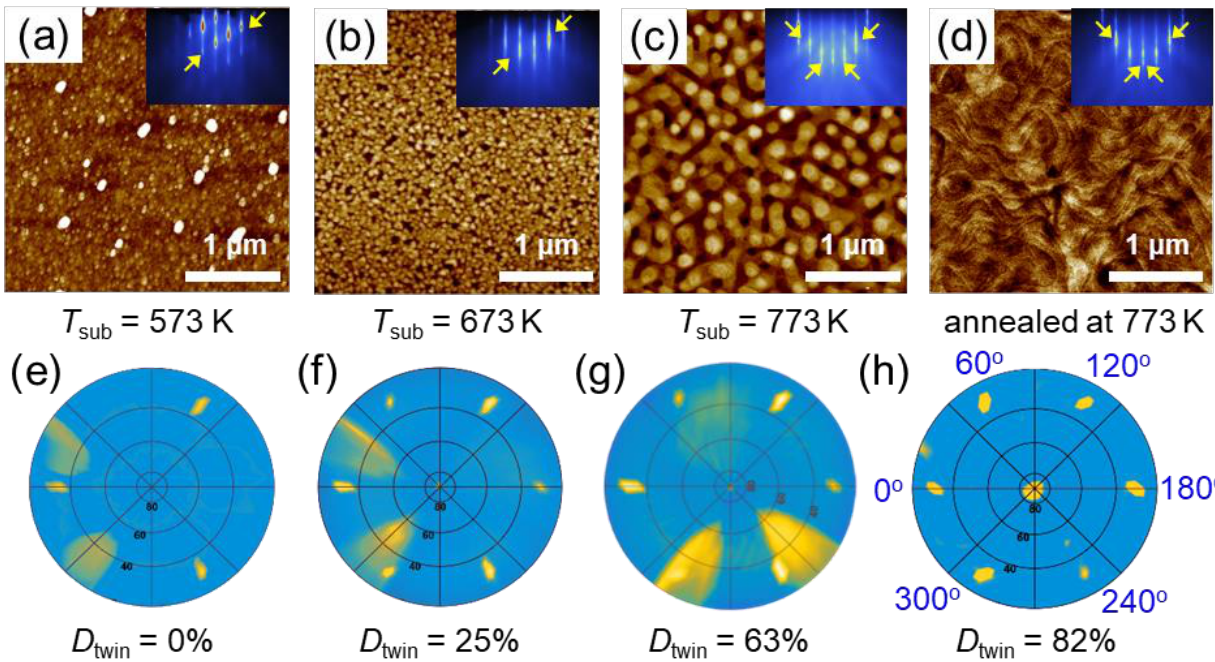
Figure 5. ( a – d ) AFM surface morphologies of the Mg 3 Sb 2 films grown at various T sub . The inserted figures show the corresponding RHEED patterns along the [11 2 0] azimuthal direction, where the intensity modulations are highlighted by yellow arrows. ( e – h ) XRD pole figures of the corresponding films shown in ( a – d ). The diffraction spots of normal domains are shown at 0 ◦ , 120 ◦ and 240 ◦ , while the spots of twin domains are evident at 60 ◦ , 180 ◦ and 300 ◦ . The D twin denotes the degree of twinning that is calculated by Rigaku smartlab software based on the intensity and area of diffraction